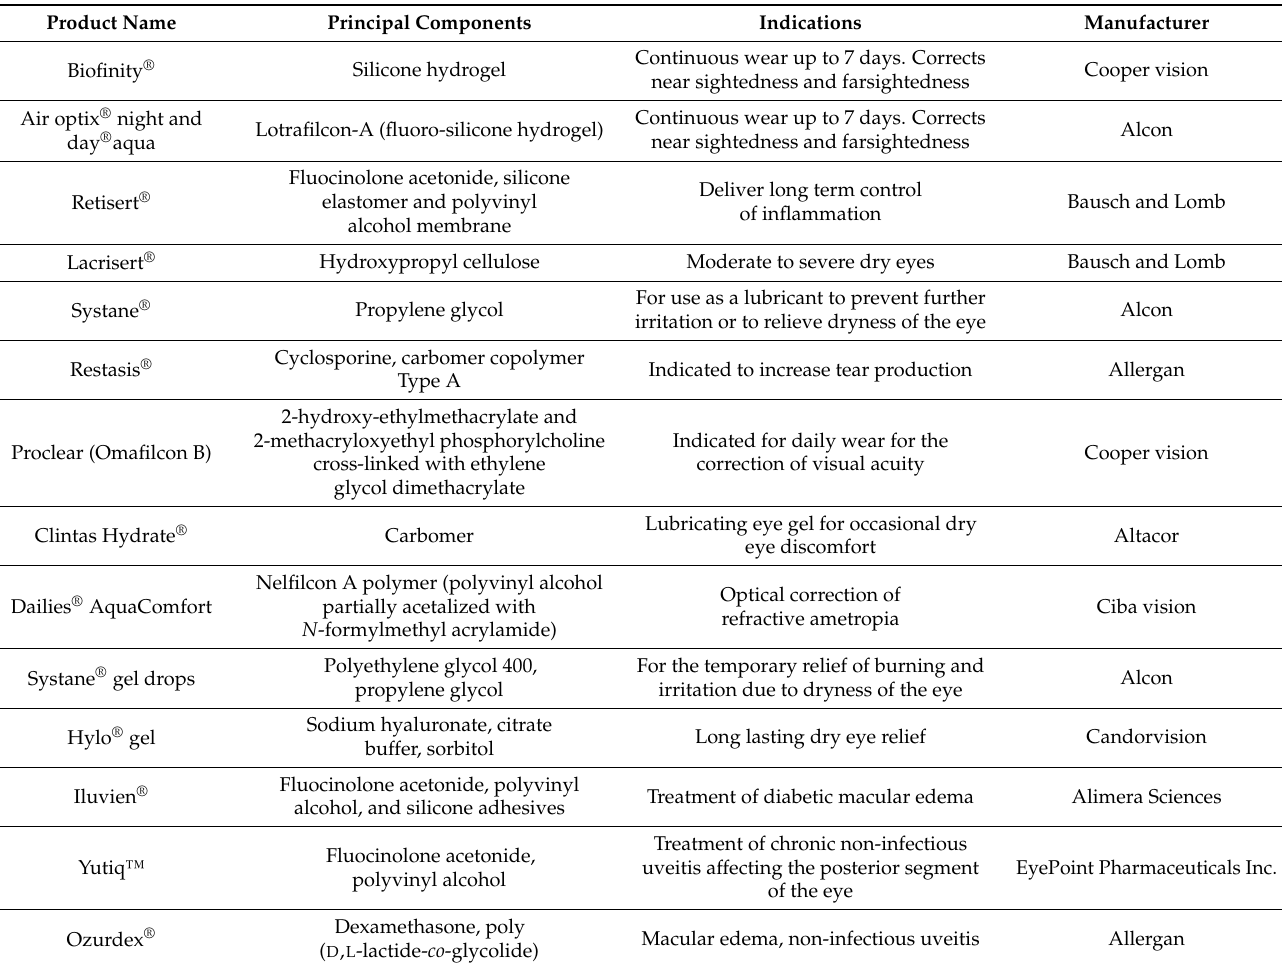
Table 4. Selected commercial examples of hydrogel-based ocular drug delivery systems and soft contact lens